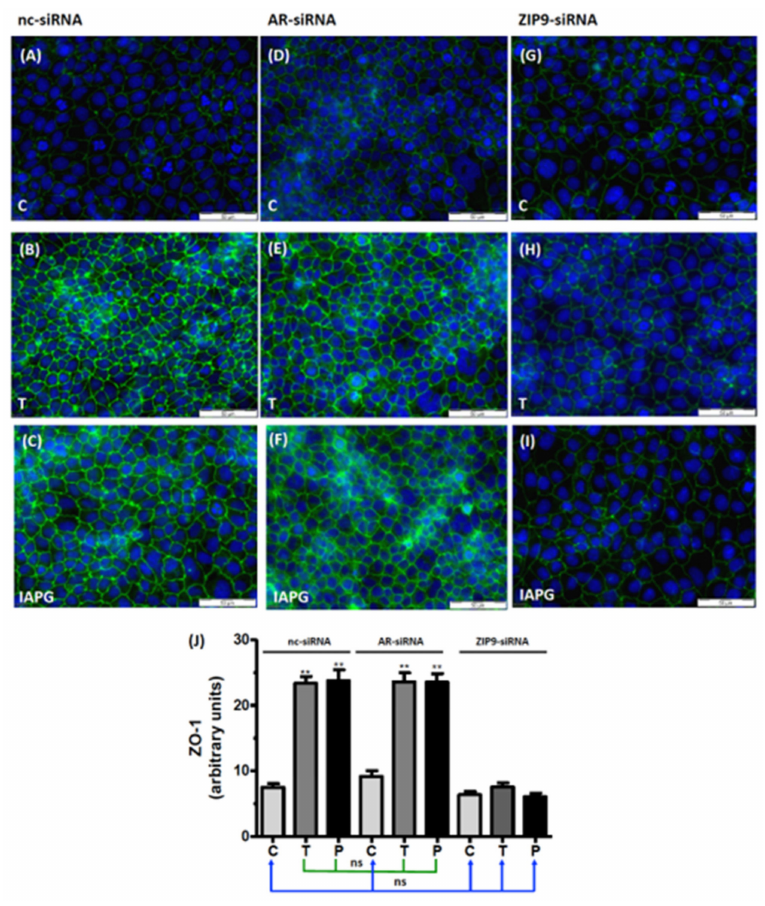
Figure 8. Immunofluorescence of ZO-1 expression in PASC1. Cells were treated with vehicle (C), 10 nM testosterone (T), or 10 µ M IAPG (P) for 24 h. Nuclei are shown as blue and ZO-1 is green. ( A – C ) ZO-1 in cells treated with nc-siRNA. ( D – F ) ZO-1 in cells treated with AR-siRNA. ( G – I ) ZO-1 in cells treated with ZIP9-siRNA. ( J ) Statistical analysis of green fluorescence shown in panels A–I ( n = 3 × 25; means ± SEM; ** p ≤ 0.01; ns = not